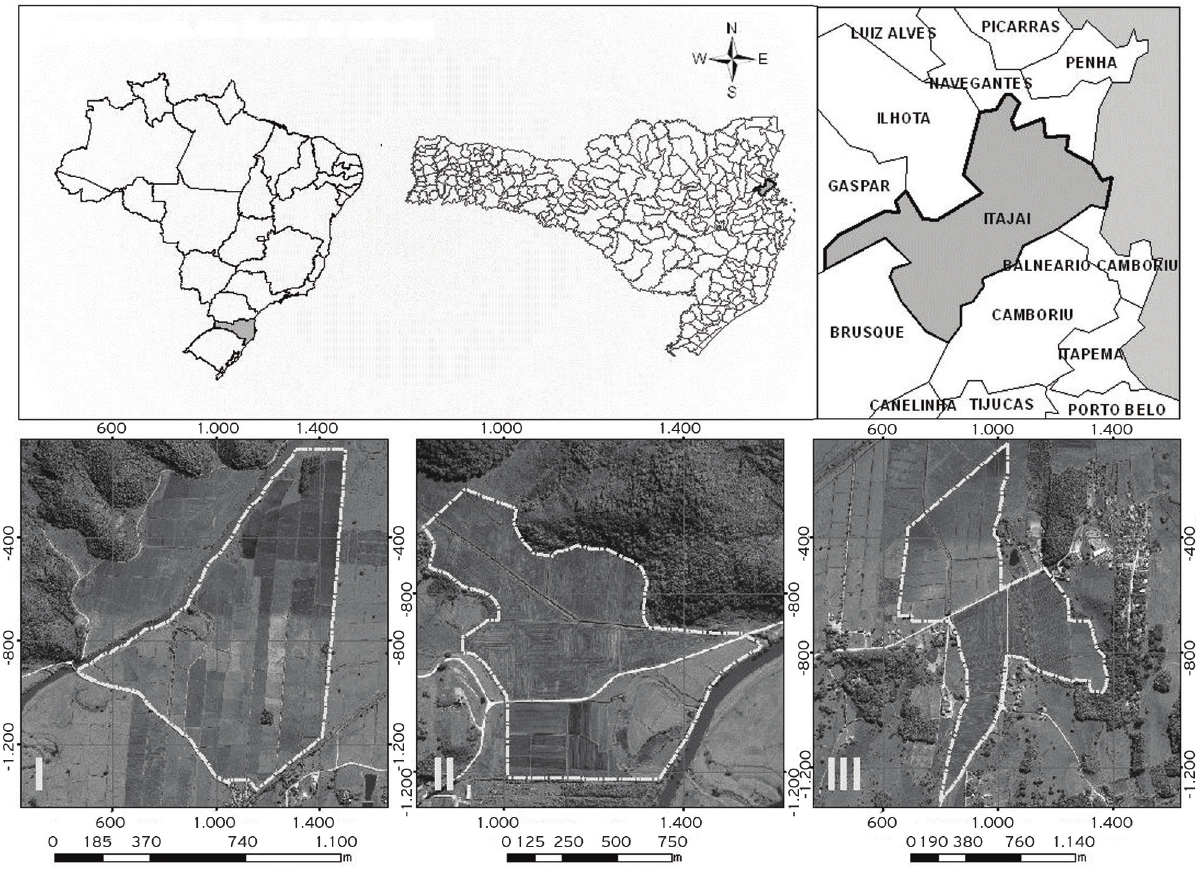
Figure 1. Location of study areas, a total of 90 hectares monitored, chosen by virtue of their ease of access in, Itajaí, Santa Catarina, Brazil.